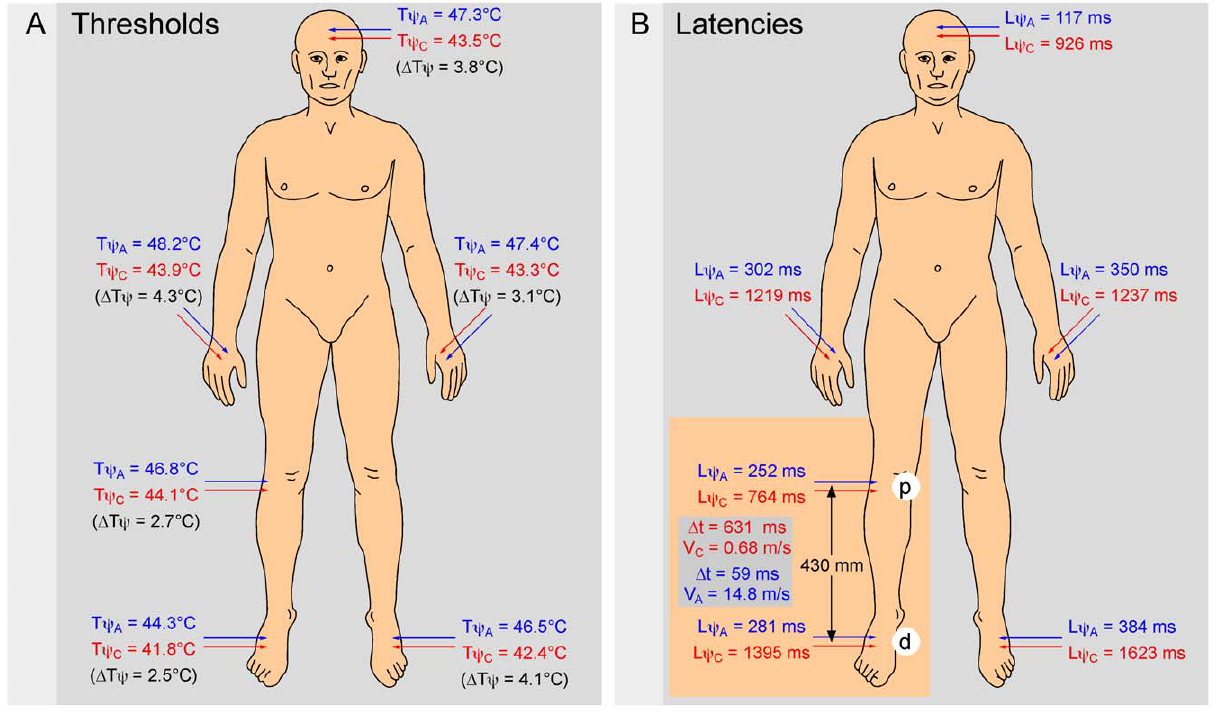
Figure 7. Thresholds and latencies from various territories. Six sites were investigated in this subject (front, hand, leg, foot) among which two belonged to the same dermatome on the lower limb (S1). - A Thresholds. The threshold T y A of the responses triggered by A d -fibers was 3–4 u C higher than the thresholds T y C of the responses triggered by C-fibers. - B Psychophysical latencies. The latencies L y A of the responses triggered by A d -fibers were several times briefer than the latencies L y C of the responses triggered by C-fibers. The stimulation of two separate sites, the first distal on the foot (d) and the second proximal on the leg (p), allowed one to estimate the conduction velocity of the fibers responsible for the responses. The difference of the latencies of the responses attributed to A d -fibers was 0.059 seconds to travel the 430 mm (from d to p), which corresponds to a conduction velocity of 14.8 m/s. The difference of the latencies of the responses attributed to C-fibers was 1.395 seconds to go the same distance, which corresponds to a conduction velocity of 0.7 m/s.